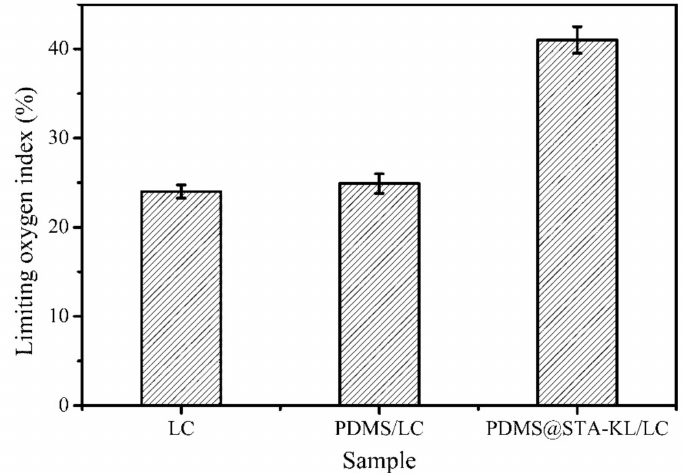
Figure 7. Limiting oxygen index values of LC, LC coated with PDMS and LC coated with PDMS@STA-KL.